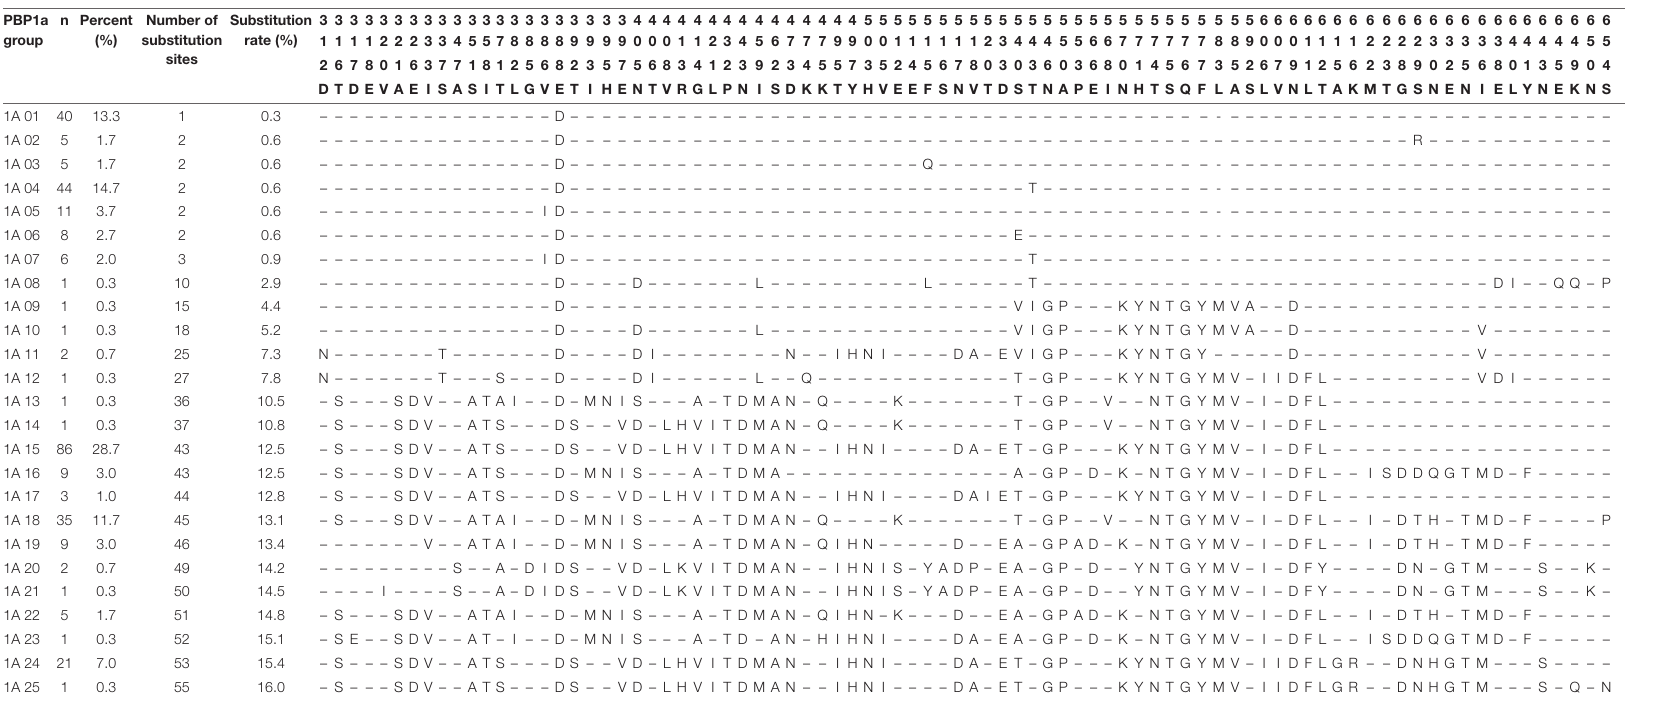
TABLE 9 | Deduced amino acid sequences of PBP1a in 300 S. pneumoniae isolates. PBP1a n Percent Number of group (%) substitution